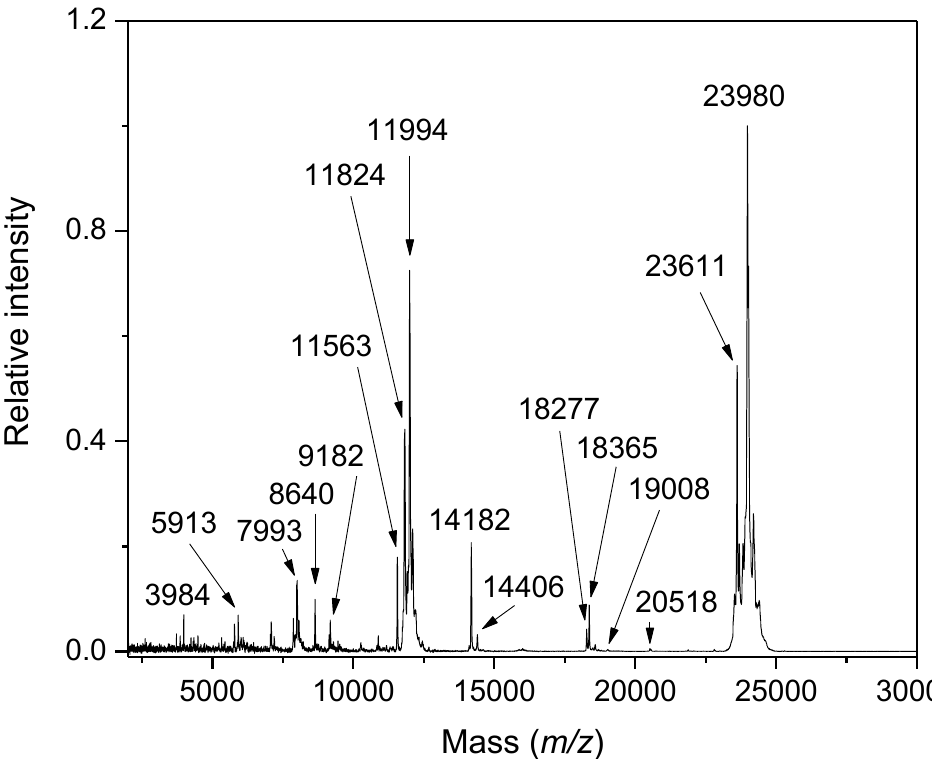
Figure 1. MALDI-TOF MS of milk. This sample of aseptically packed fresh milk was measured using an ultrafleXtreme instrument (Bruker Daltonics). The depicted spectrum was acquired in the linear positive ion mode with a stainless-steel target and sinapinic acid (SA) as a matrix according to Fanton et al. [27]. Many peptides were detected at masses below 6 kDa such as that at m/z 3984, which is a fragment of α S1 -casein [28]. Major protein peaks refer to γ 3 -casein ( m/z 11,563), γ 2 -casein ( m/z 11,824), α -lactalbumin ( m/z 14,182), β -lactoglobulin ( m/z 18,277 and 18,365—two variants), κ -casein ( m/z 19,008), γ 1 -casein ( m/z 20,518), α S1 -casein ( m/z 23,611), and β -casein ( m/z 23,980). The content is